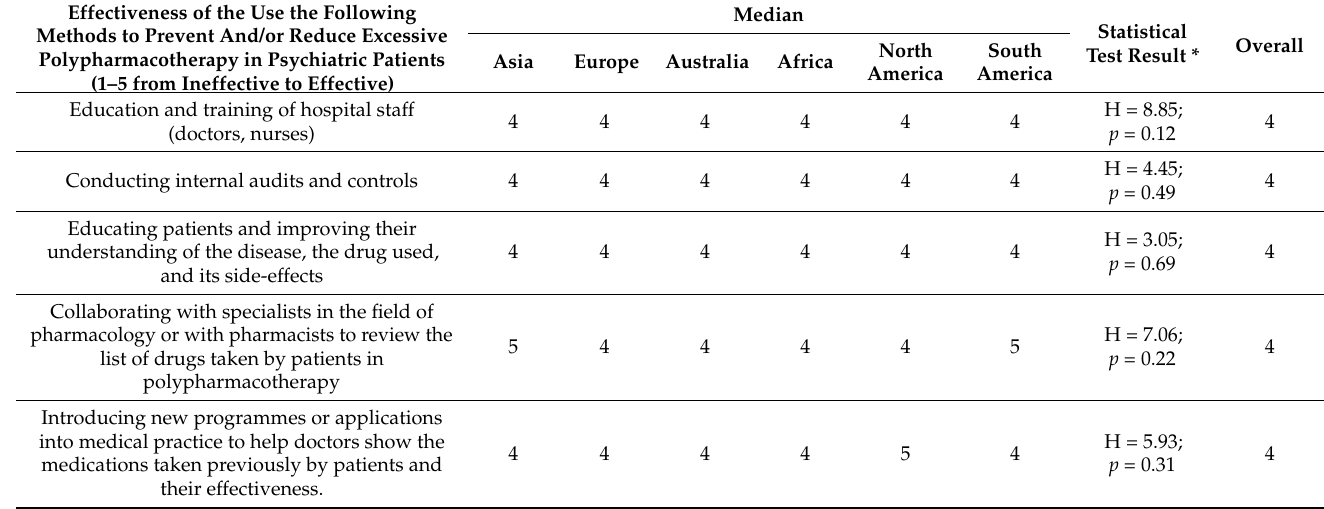
Table 8. Psychiatrists’ answers on preventing and/or reducing excessive polypharmacotherapy in psychiatric